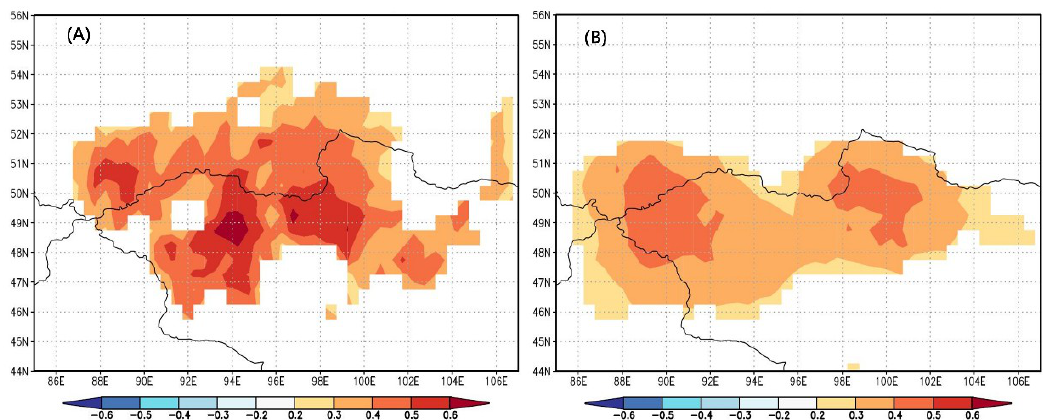
Figure 5. ( A ) Correlation of actual and estimated June PDSI during the period of 1965 – 2016; ( B ) Comparison of actual and estimated June PDSI 1965–2016. ( C ) Tree‐ring reconstructed June PDSI plotted annually (blue line) 1731–2016, along with a smoothed 10‐year moving average (red line).